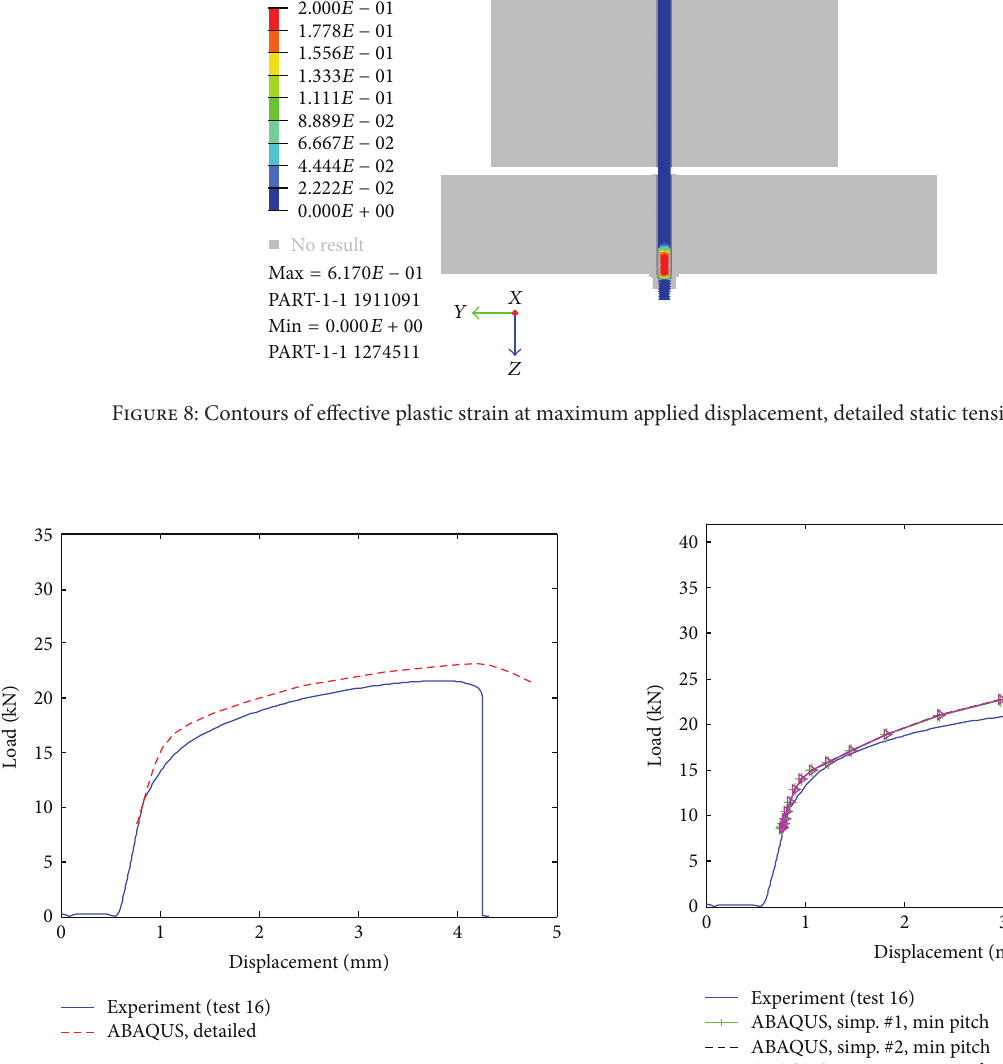
Figure 9: Force-displacement results for static tension test, detailed model.